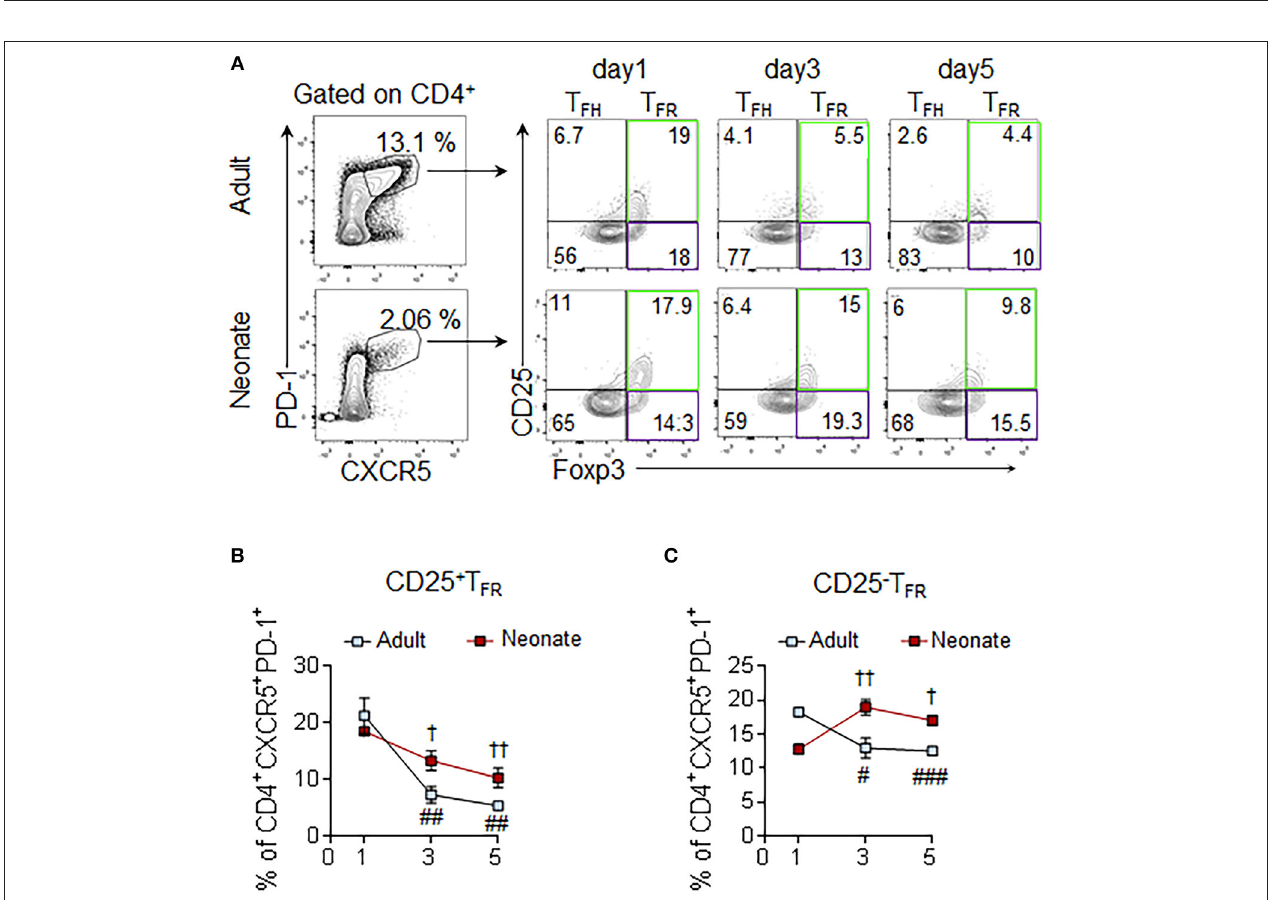
FIGURE 4 | plotted ( n = 4). Splenic GC, FRC, and Foxp3 + cells were examined by microscopy at 14 dpi (B-G) . (B) B220 + GL7 + GCs and GC B cells (merged pink color) are shown. (C) Representative image of adult T cell-zones, defined as areas where CD4 and FRC are co-localized, is shown. Podoplanin is used as a marker of FRC. (D-G) Distribution of T reg cells in adult and neonatal spleen is depicted. (E) Follicles (B220 + B cell area) were outlined using white and blue lines. Blue line demarks T-B border. Foxp3 + cells in interfollicular niches (solid arrows) (D) or within follicle (dotted arrows) (F) were quantified in half spleen and means of cells in each compartment were plotted. (G) Foxp3 + cells in T cell-zone within FRC area were captured in box (left) and enlarged (right). Each dot represents follicles from four mice, representative of two experiments. Magnification 10x. FRC, follicular reticular cell. * p < 0.05, ** p < 0.01, *** p < 0.001 depict comparisons between adult and neonatal mice.